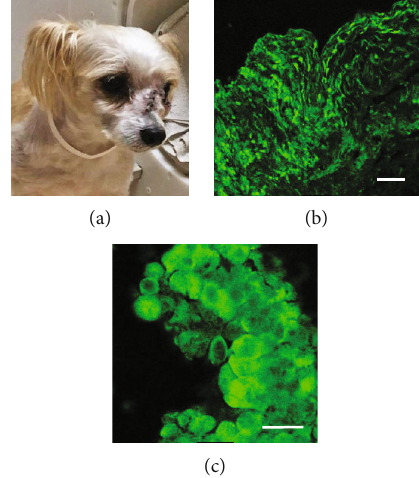
Figure 7: The photograph in (a) depicts the appearance of a large mass that involved the right orbit and at the time of presentation had erupted through the skin over the bridge of the nose and face. The low-power (b) and high-power (c) photomicrographs depict the prominent immunohisto fl uorescent labeling of VGSCs (green) revealed in a tissue sample taken from the tumor in (a) before treatment with TOL. The calibration bar for photomicrographs in (b) and (c) is 50 and 25 μ m,